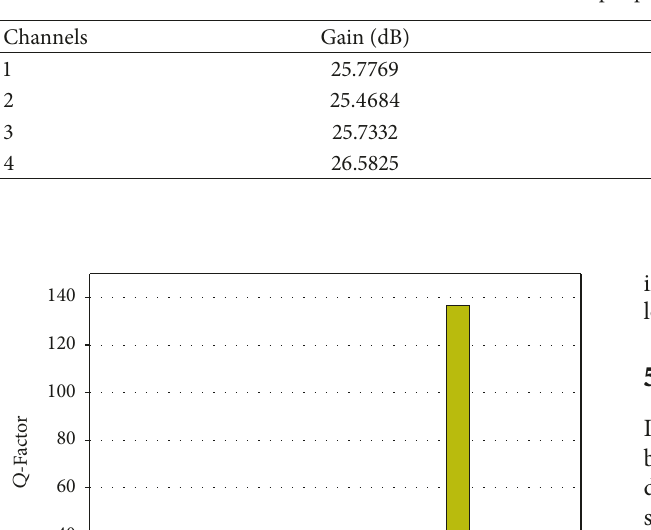
Table 3: Gain, NF, and output power of WDM technology.